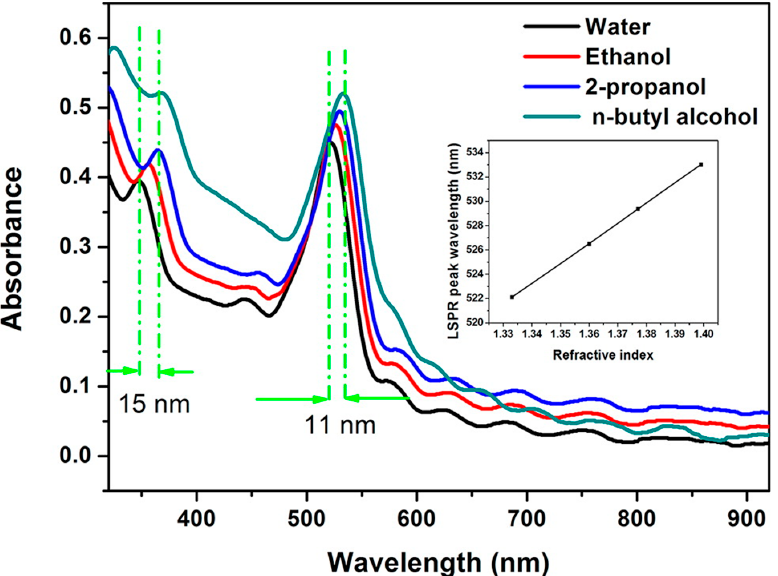
Figure 6. Absorption spectra of i-Au-SiO 2 -o films with 277 nm pores infiltrated with media of varying RIs as follows: ( a ) water ( n = 1.333); ( b ) ethanol ( n = 1.360); ( c ) 2-propanol ( n = 1.377); and ( d ) N-butyl alcohol ( n = 1.399). The inset is the plot of the LSPR peak wavelength as a function of the refractive index of the surrounding medium [34].